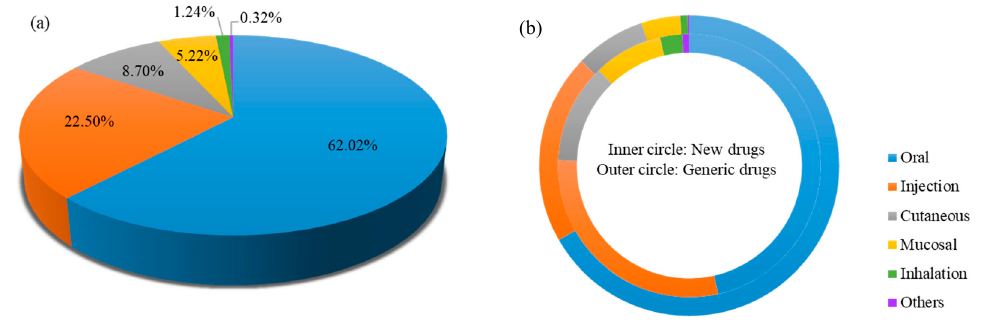
Figure 3. ( a ) The overall distribution of administration route of FDA-approval pharmaceutical products. ( b ) The proportion of administration route. Inner circle represents drugs; Outer circle represents generic drugs.